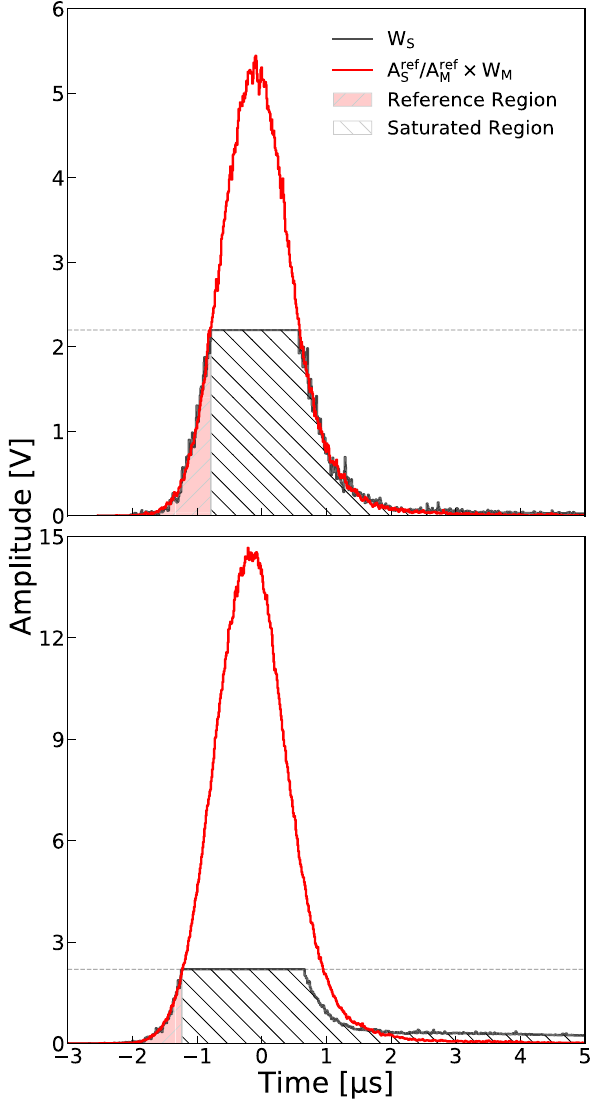
Fig. 1 Examples of saturated WFs from two S2s with a size of about 2 × 10 5 PE (top) and 10 6 PE (bottom). Each panel shows a WF (black) in one channel centred to time zero. Both WFs are truncated due to the range of the digitizer. The WF model, obtained from the sum of non- saturated WFs, is scaled and overlaid in the plot (red). The red shaded region each covers 1 µ s before the first truncated sample and used as a reference region, while the hatched region from the first truncated sample to the end of the pulse covers the range where WFs are corrected as the scaled WF